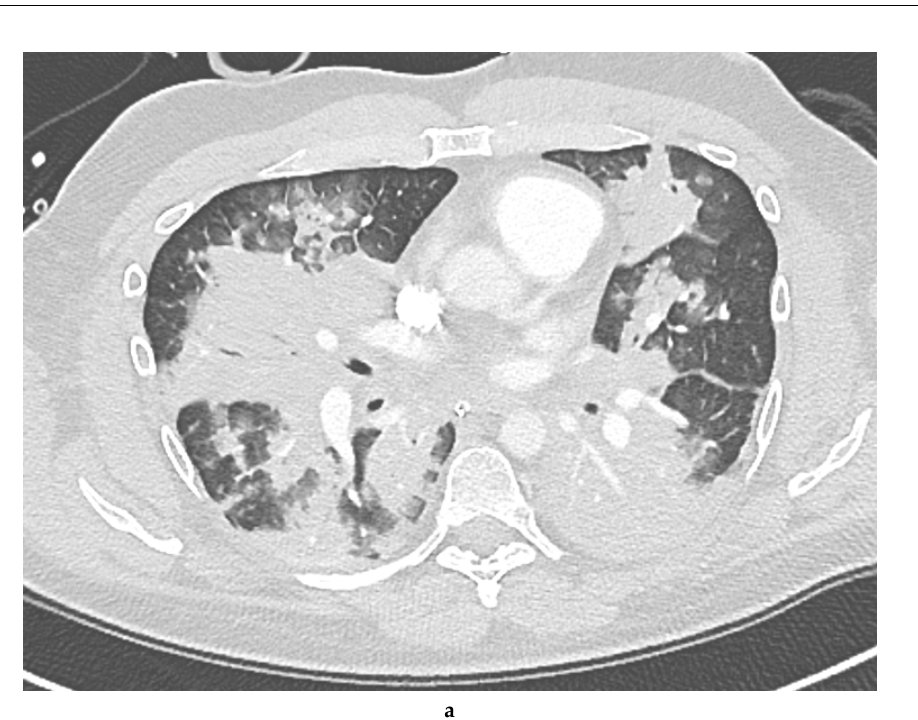
b Figure 1. A 42 ‐ year ‐ old male presented with petechiae and the deterioration of general condition. The initial laboratory workup was especially notable for hemoglobin 6.9 g/dL and thrombocytes 1 G/L. Laboratory testing was positive for Anti ‐ GPIb/IX ‐ antibodies, consistent with the diagnosis of primary immune thrombocytopenia. Dexamethasone for 3 days was started. Six days later, during